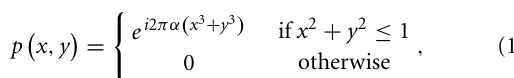
results using a transparent fluorescent slab demonstrate that the volume projection imaging path results in clearer separation of the region-of-interest signals when compared with the conventional imaging path. Note that the contrast conserves the number of photons in each image. (E) Wide-field imaging results comparing the conventional and volume projection imaging techniques. Note that each image is normalized to the respective peak